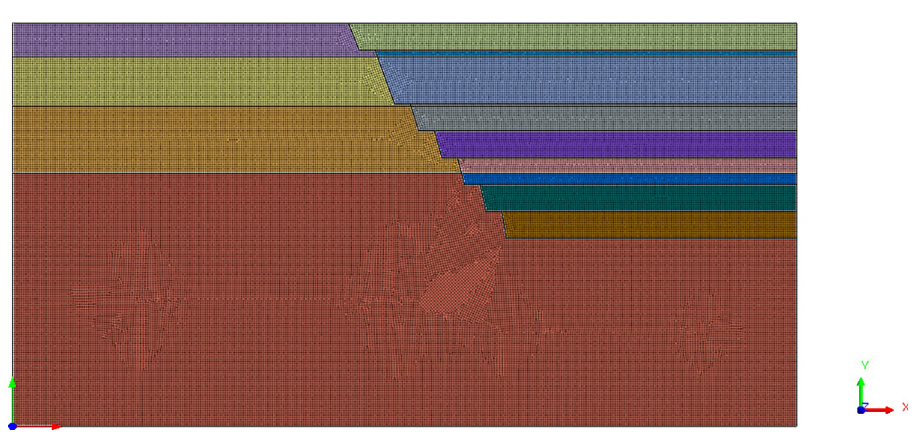
Fig 6. Excavation model of slope.